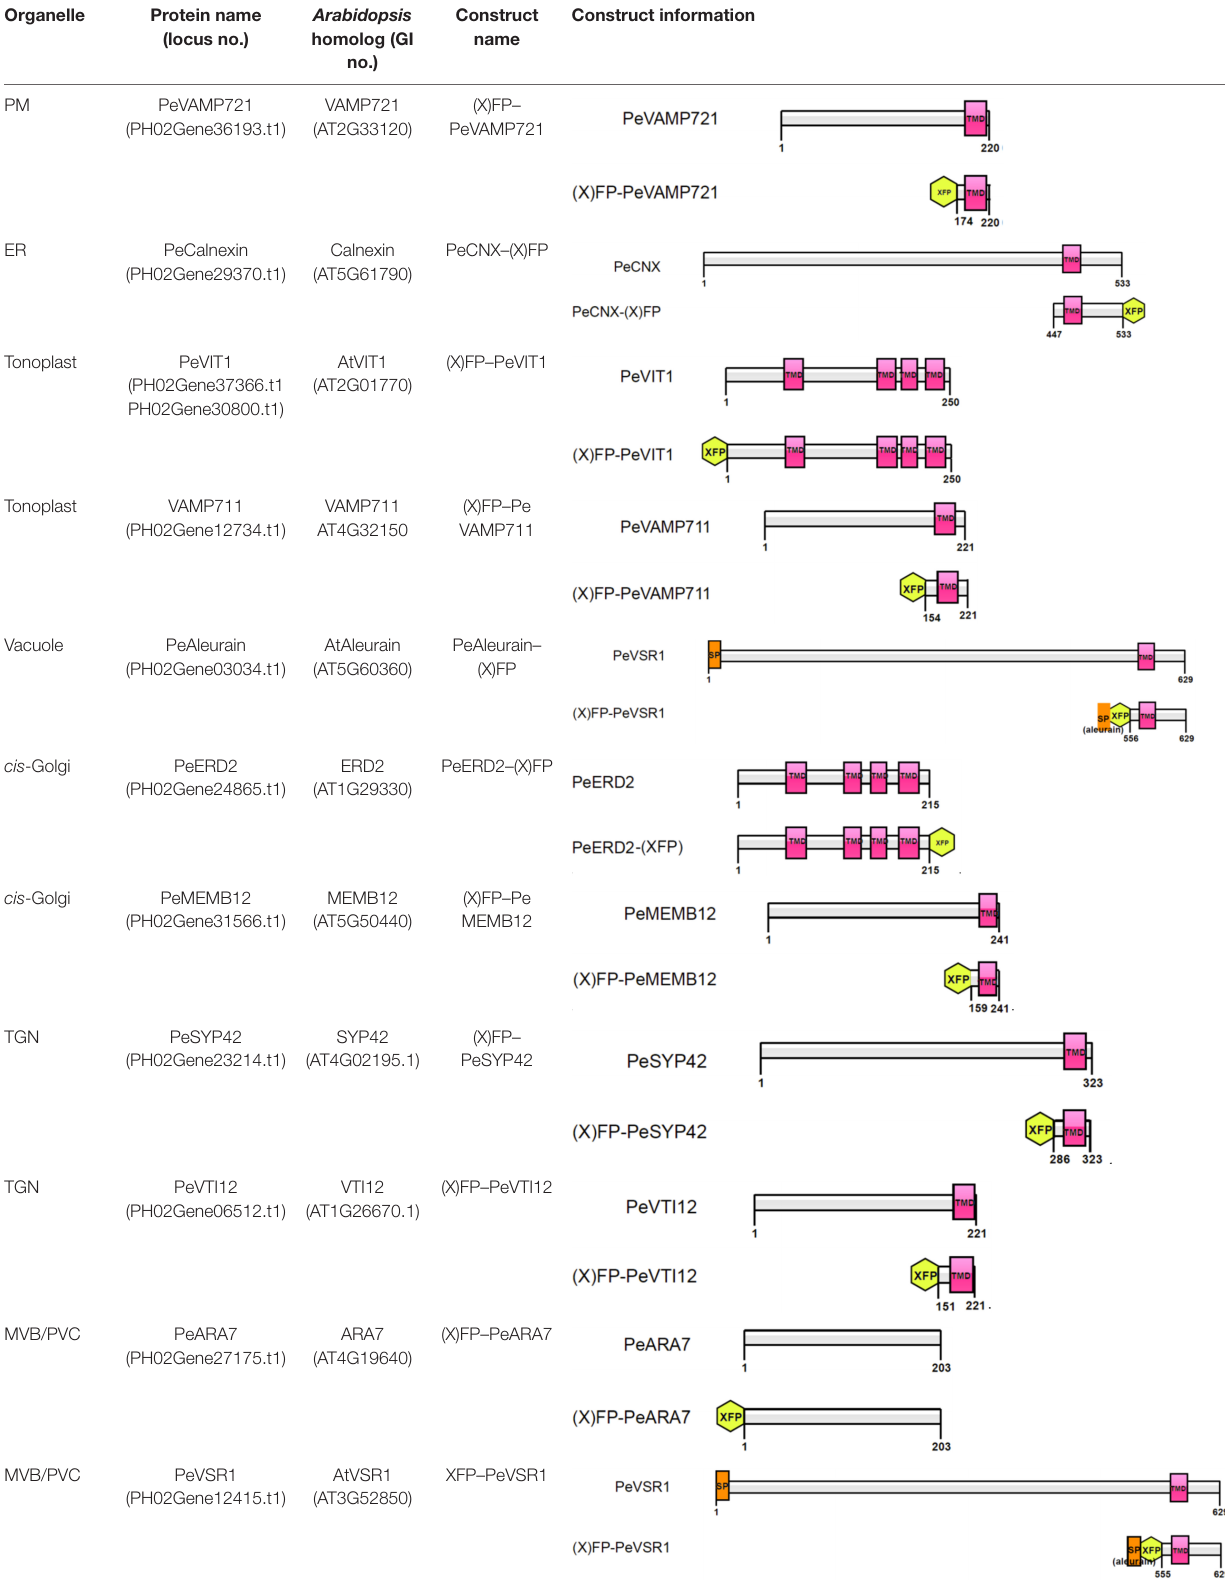
TABLE 1 | Construct information of the organelle markers in moso bamboo protoplasts. Organelle Protein name Arabidopsis (locus no.) homolog (GI